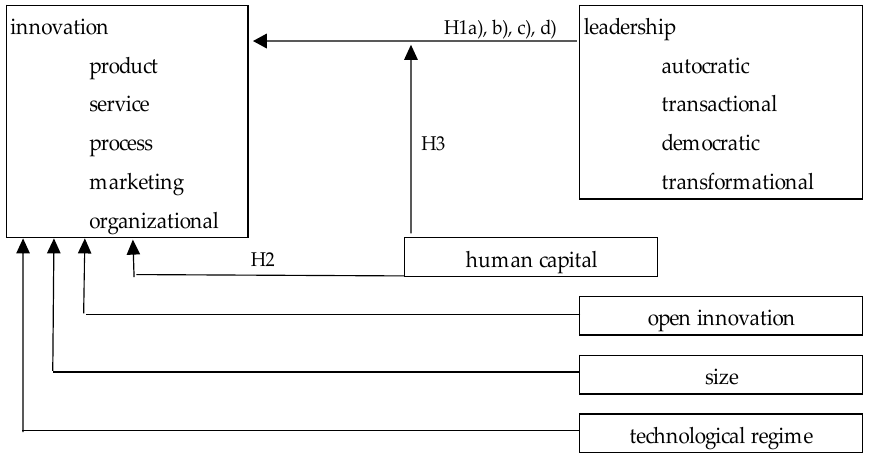
Figure 1. Conceptual model and hypotheses in test.